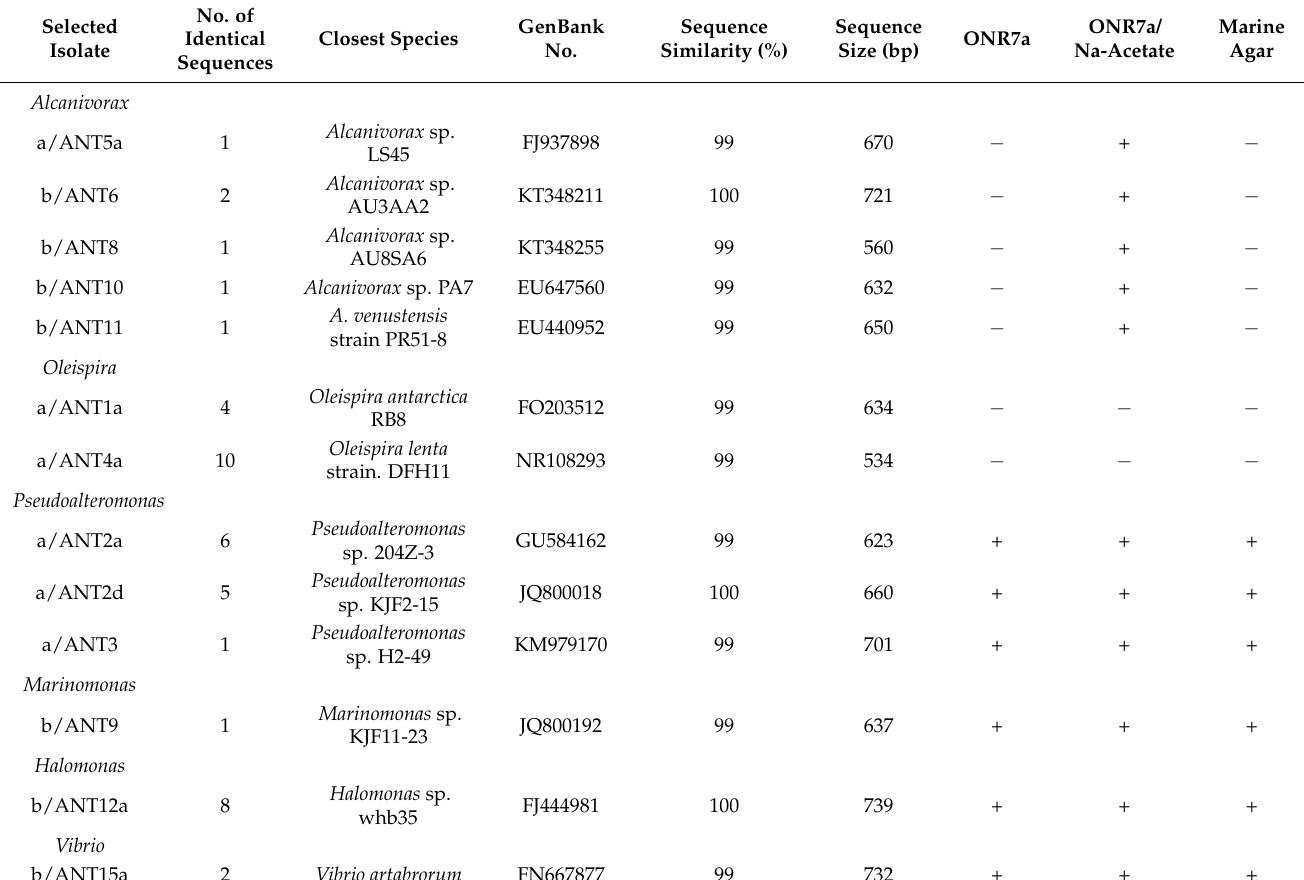
Table 1. Phylogenetic relationships of the examined bacterial isolates and results of growth tests performed on different solid culture